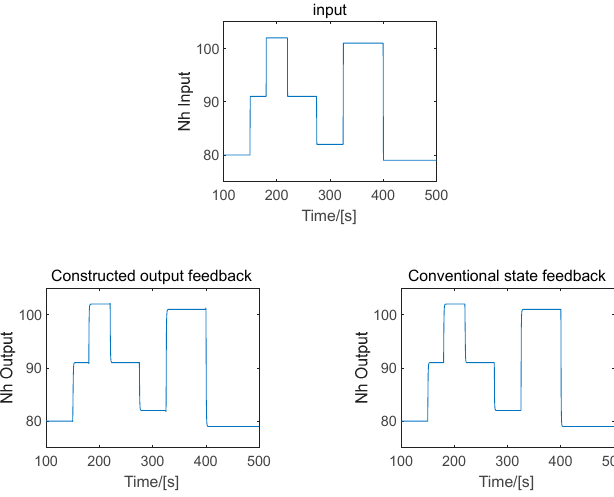
Figure 9. High-pressure rotor speed response curve.